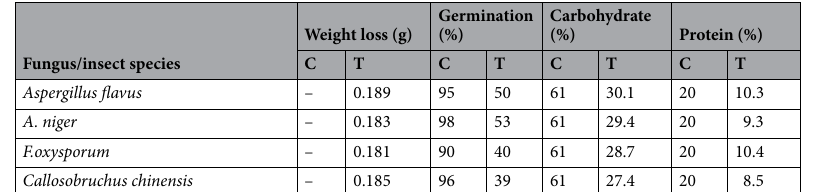
Table 2. Evaluation of effect of Fungal/insect species on chickpea food seeds after 21 days storage. C control, T treatment. –: Nil.